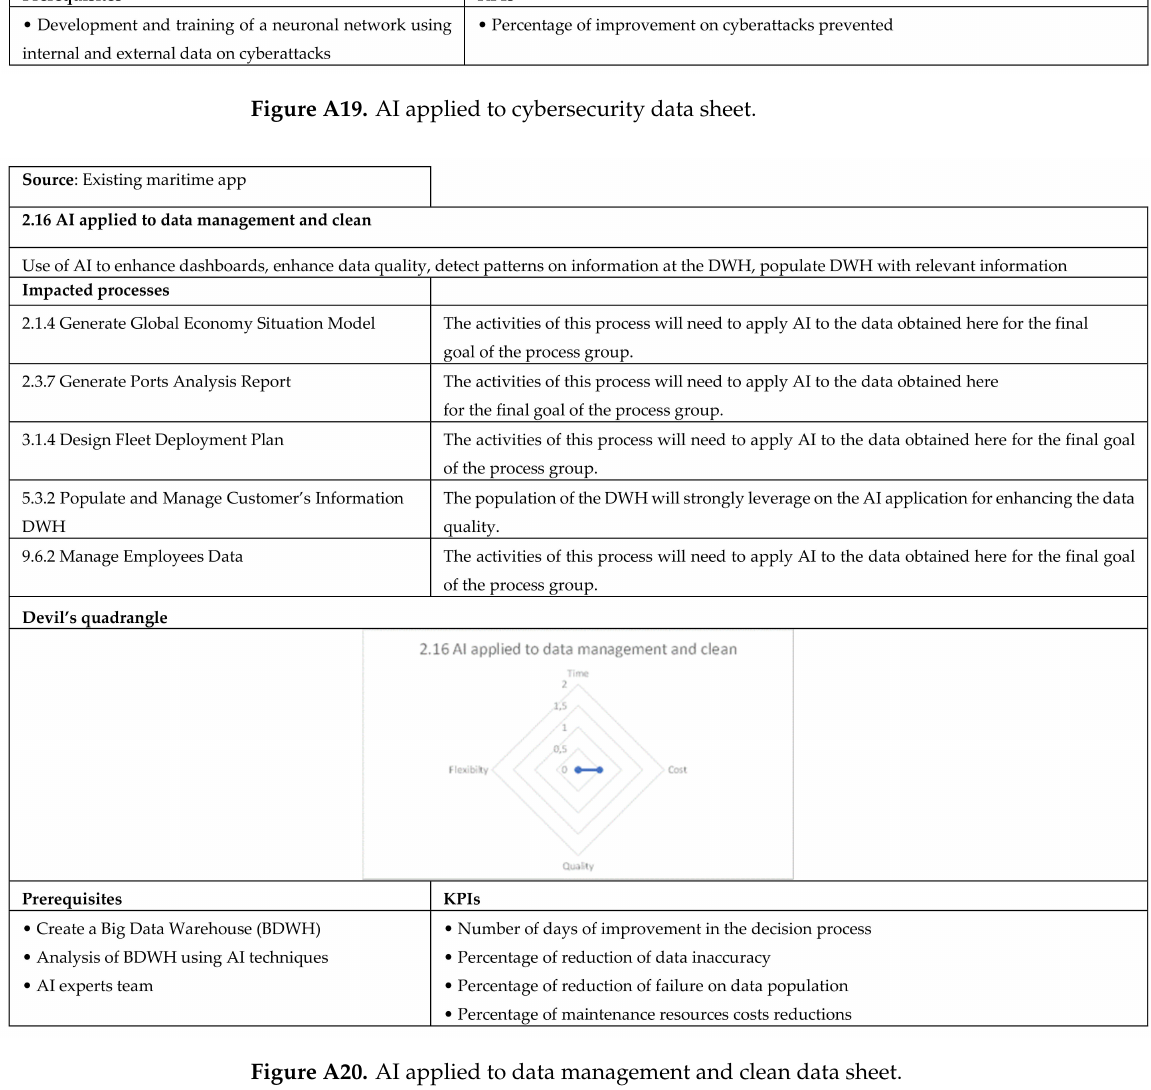
Figure A20. AI applied to data management and clean data